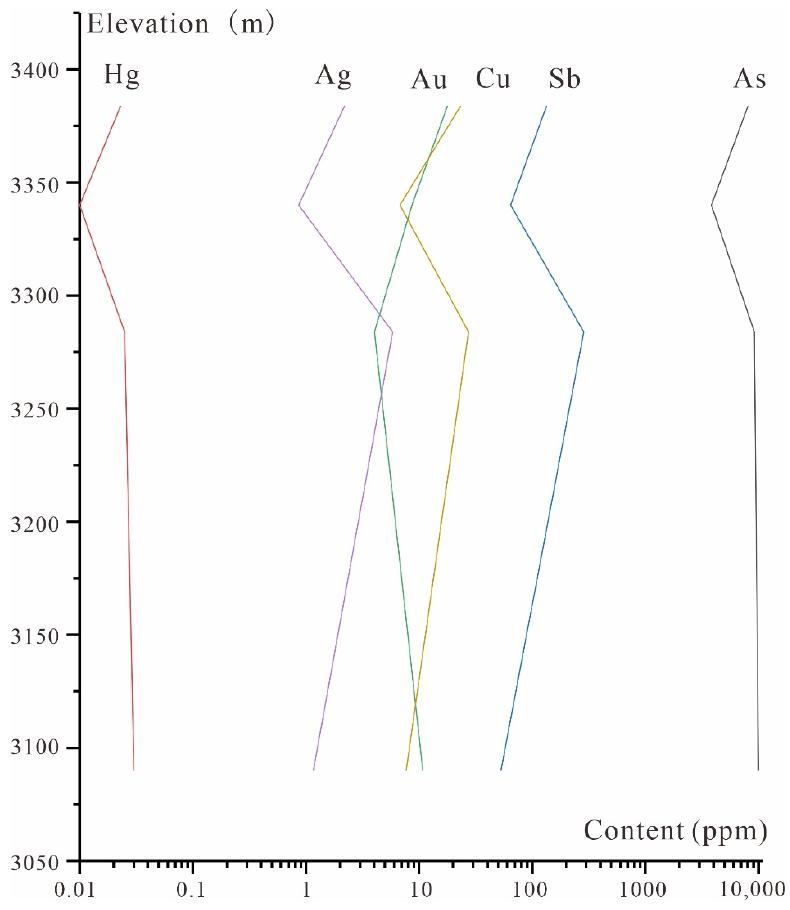
Figure 10. Changes in elemental concentrations in the supra-ore halo with height. Differences in the contents of supra-ore halo elements (As, Hg, Sb, and Ba), near-ore halo elements (Pb, Ag, Au, Zn, and Cu), and sub-ore halo elements (W, Bi, Mo, Ni, Cd, Co, and Ti) were examined by comparison with the wall-rocks of the Yanjingou Au deposit and average for the Wulonggou Au district (Table 4). This analysis showed high contents of As, Hg, and other elements in the supra-ore halo; Ag, Au, and other elements in the near-ore halo are high; and W, Mo, and other elements in the sub-ore halo. Table 4. Element anomaly for the four elevations in the Yanjingou Au deposit.